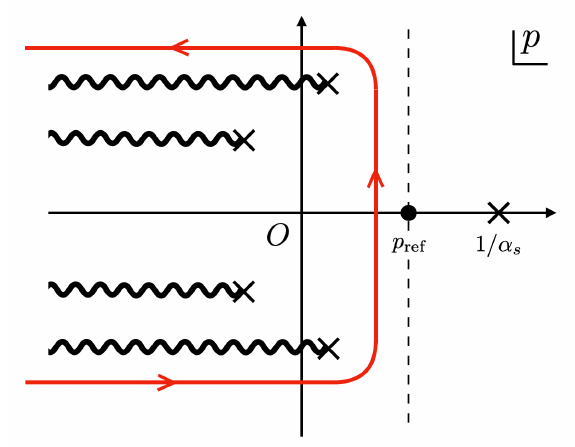
Figure 12 . Contour of p integration surrounding singularities in the p plane. These singularities correspond to all the singularities except p ∗ , 1 in the region τ a < µ , and to all the singularities in the region τ a > µ